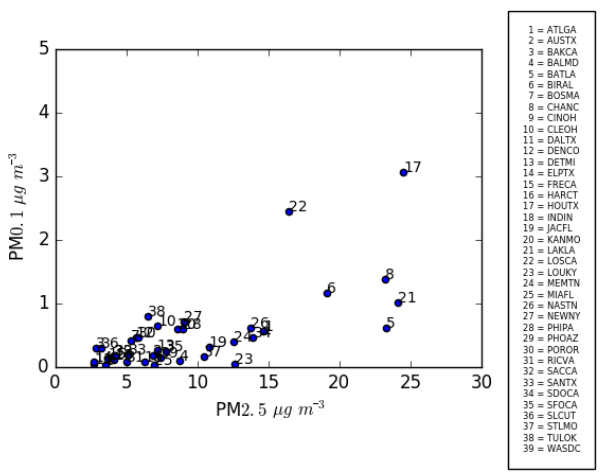
Figure 10. Scatter plot showing correlation between 24h average PM 2 . 5 and PM 0 . 1 for the 39